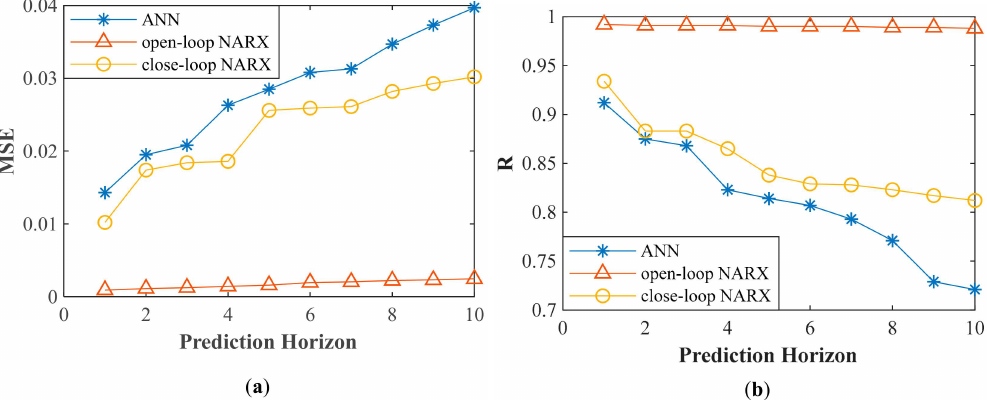
Figure 12. Performance of brake intensity predciton using Artificial Neural Networks (ANN) open-loop, and close-loop NARX networks. ( a ) Performance of the mean square error (MSE) with di ff erent prediction horizon; ( b ) Performance of the correlation coe ffi cient (R) with di ff erent prediction